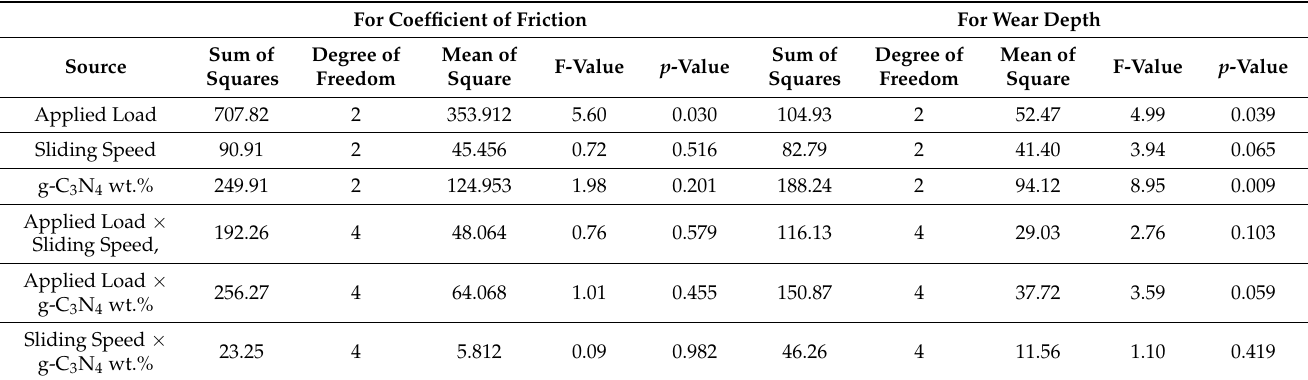
Table 6. Analysis of variance (ANOVA) for signal-to-noise (SN)